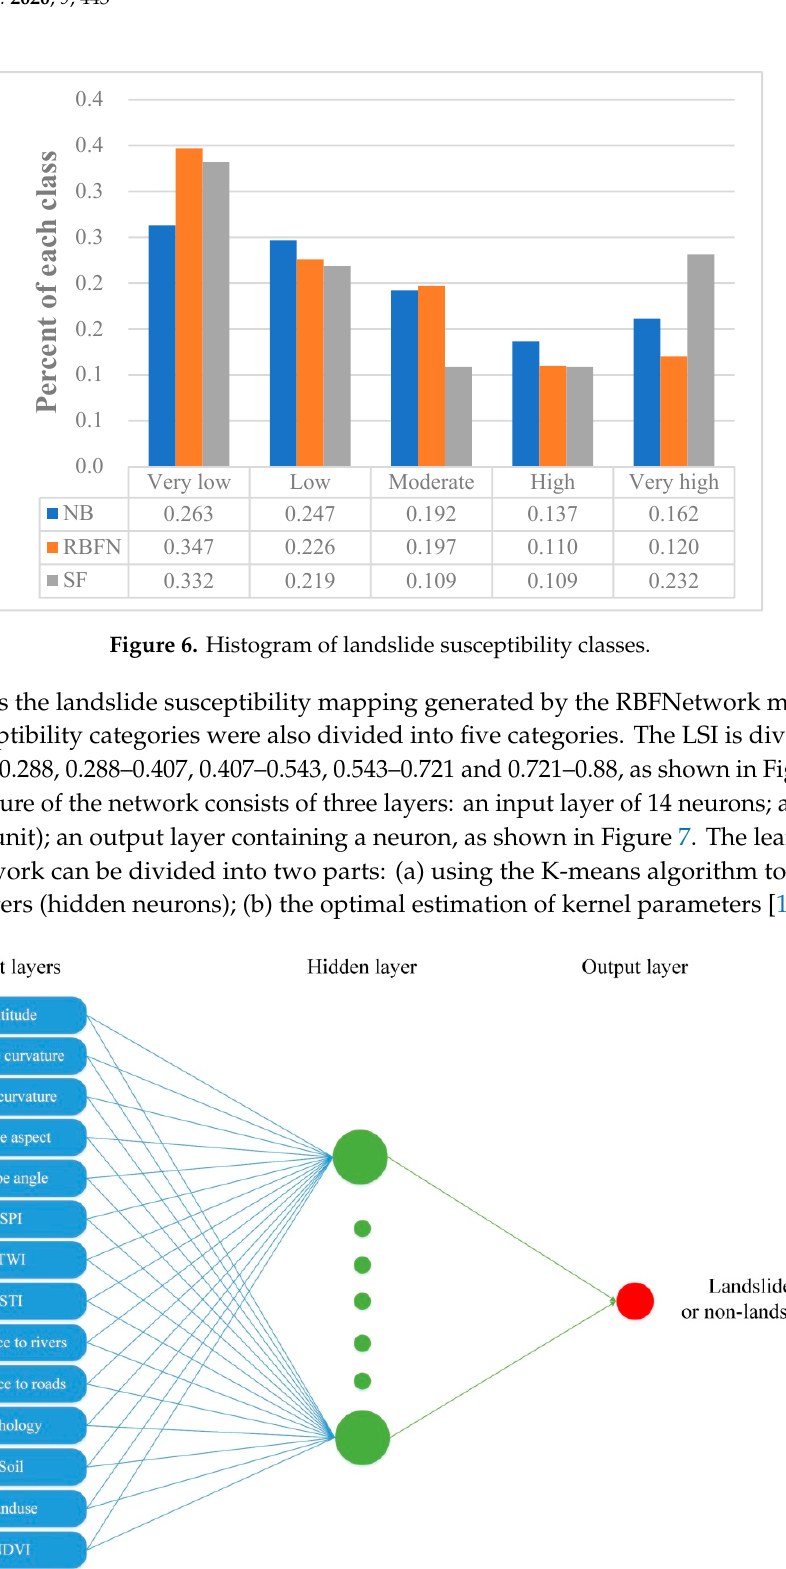
Figure 7. RBFNetwork used in this study.